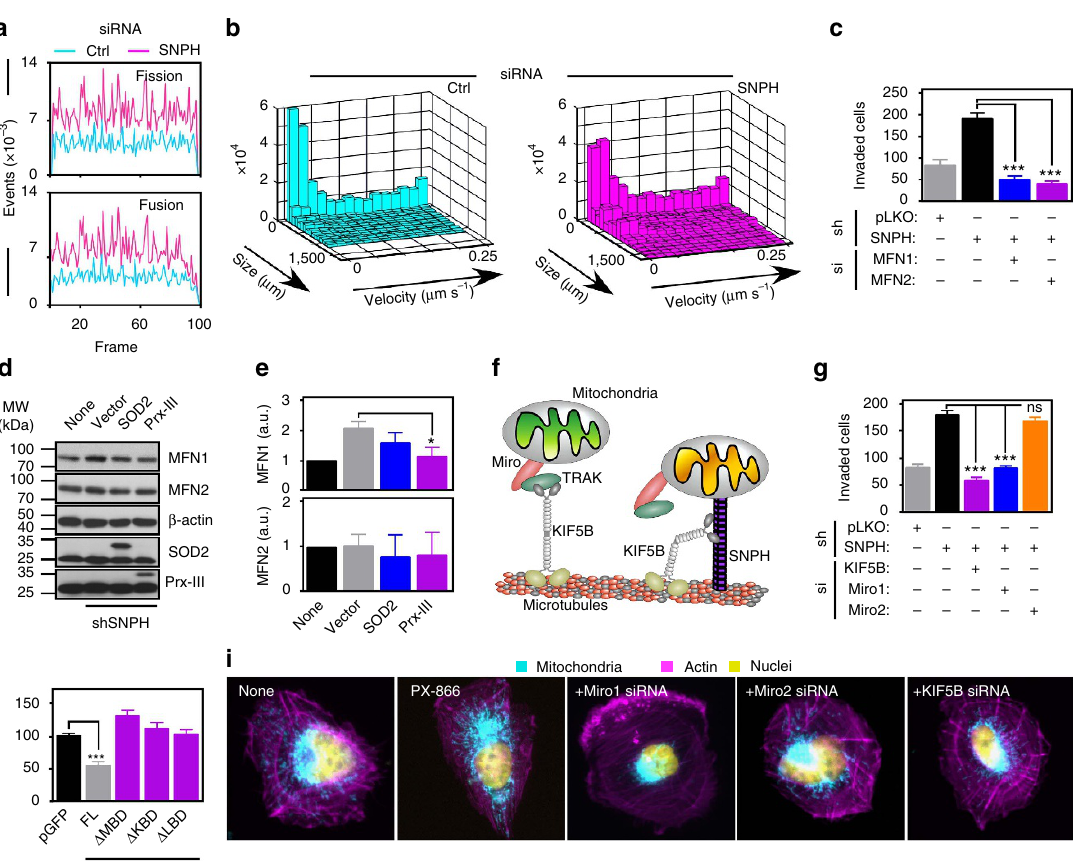
Figure 3 | SNPH regulation of mitochondrial dynamics. ( a ) LN229 cells transfected with control siRNA (Ctrl) or SNPH-directed siRNA were labelled with Mito-RFP and mitochondrial fission and fusion events were quantified in individual frames of time lapse microscopy. ( b ) Combined histograms of mitochondrial size and velocity data. Large mitochondria are slow moving (speed o 0.05 m ms (cid:2) 1 ) compared with smaller mitochondria (speed up to 0.25 m ms (cid:2) 1 ). ( c ) PC3 cells stably expressing pLKO or SNPH-targeting shRNA #0 were transfected with siRNA against MFN1 or MFN2 and analysed for Matrigel invasion. Data are expressed as mean ± s.e.m. ( n ¼ 3). *** P o 0.001 by one-way ANOVA and Bonferroni’s post test. ( d , e ) PC3 cells stably expressing pLKO or SNPH-targeting shRNA were transfected with cDNAs for SOD2 or PRX-III and analysed by Western blotting ( d ), with quantification of bands by densitometry and normalization to b -actin levels ( e ). Data are expressed as mean ± s.e.m. ( n ¼ 3).* P o 0.05 by one-way ANOVA and Bonferroni’s post test. ( f ) Schematic model for mitochondrial trafficking and immobilization in neurons. The implicated molecules in the SNPH network are indicated. ( g ) PC3 cells stably expressing pLKO or SNPH-directed shRNA were transfected with siRNA against KIF5B, Miro1 or Miro2, and analysed for Matrigel invasion. Data are expressed as mean ± s.e.m. ( n ¼ 3). *** P o 0.001 by one-way ANOVA and Bonferroni’s post test. ns, not significant. ( h ) PC3 cells were transfected with pGFP, full length (FL) SNPH or SNPH deletion mutants lacking the microtubule-binding domain ( D MBD), kinesin-binding domain ( D KBD) or LC8-binding domain ( D LBD) and analysed for Matrigel invasion. Data are represented as mean ± s.e.m. ( n ¼ 3). *** P o 0.0001 by Student’s t test. ( i ) LN229 cells transfected with the indicated siRNAs were treated with the small molecule PI3K inhibitor, PX-866 (5 m M, 48h) to induce